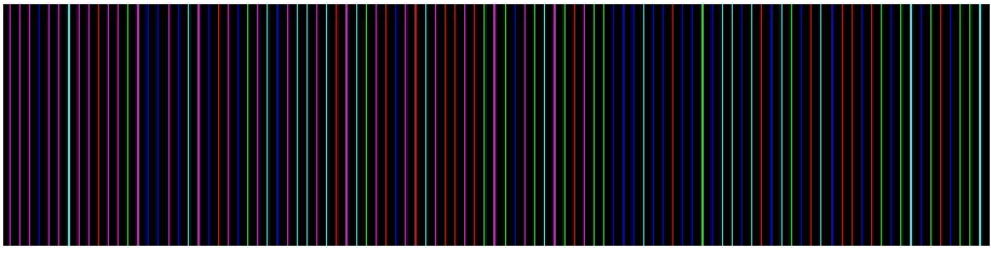
Figure 1. The cut-out of generated stripe